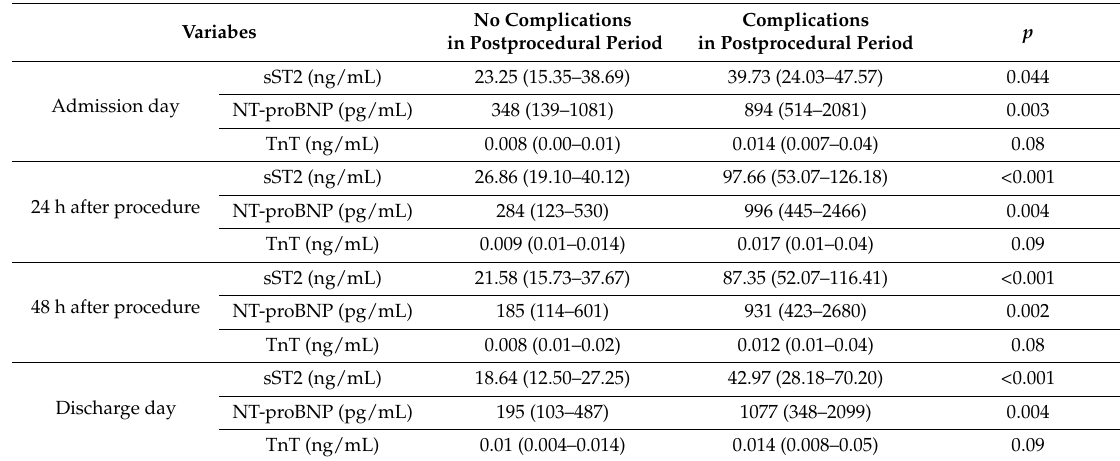
Table 4. Concentrations of sST2, NT-proBNP, and TnT separately for groups with and without complications in the postprocedural period at four time points.